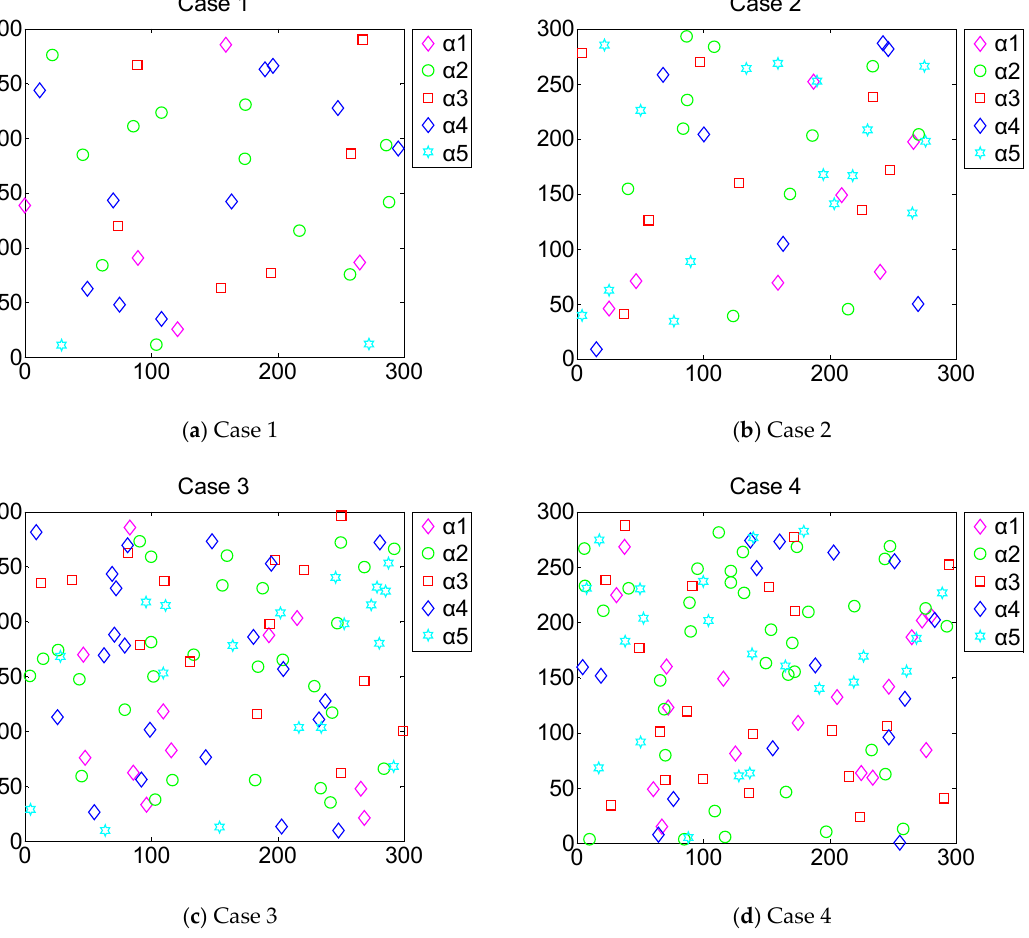
Figure 2. The CONN algorithm was applied for the deployment of five different types of sensors under four different network constraints in Case 1 to Case 4.